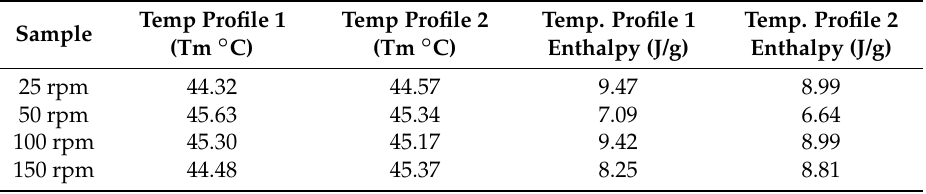
Table 4. Endothermic peak (melting point) and enthalpy values for each sample.